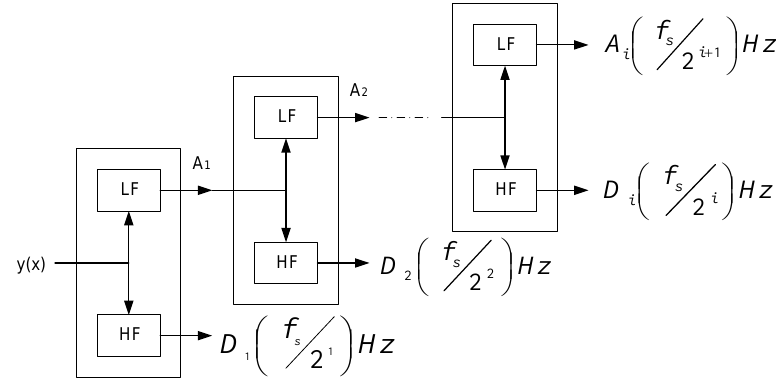
Figure 7. Wavelet transform. Frequency bands related to decomposition steps.